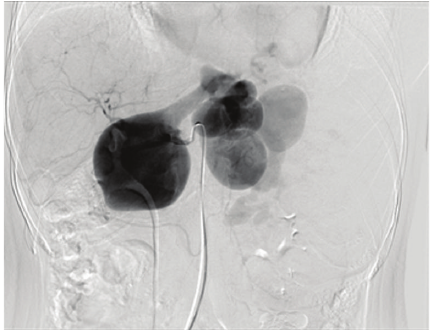
Figure 2: Selective angiography shows the multiple aneurysms along splenic artery.